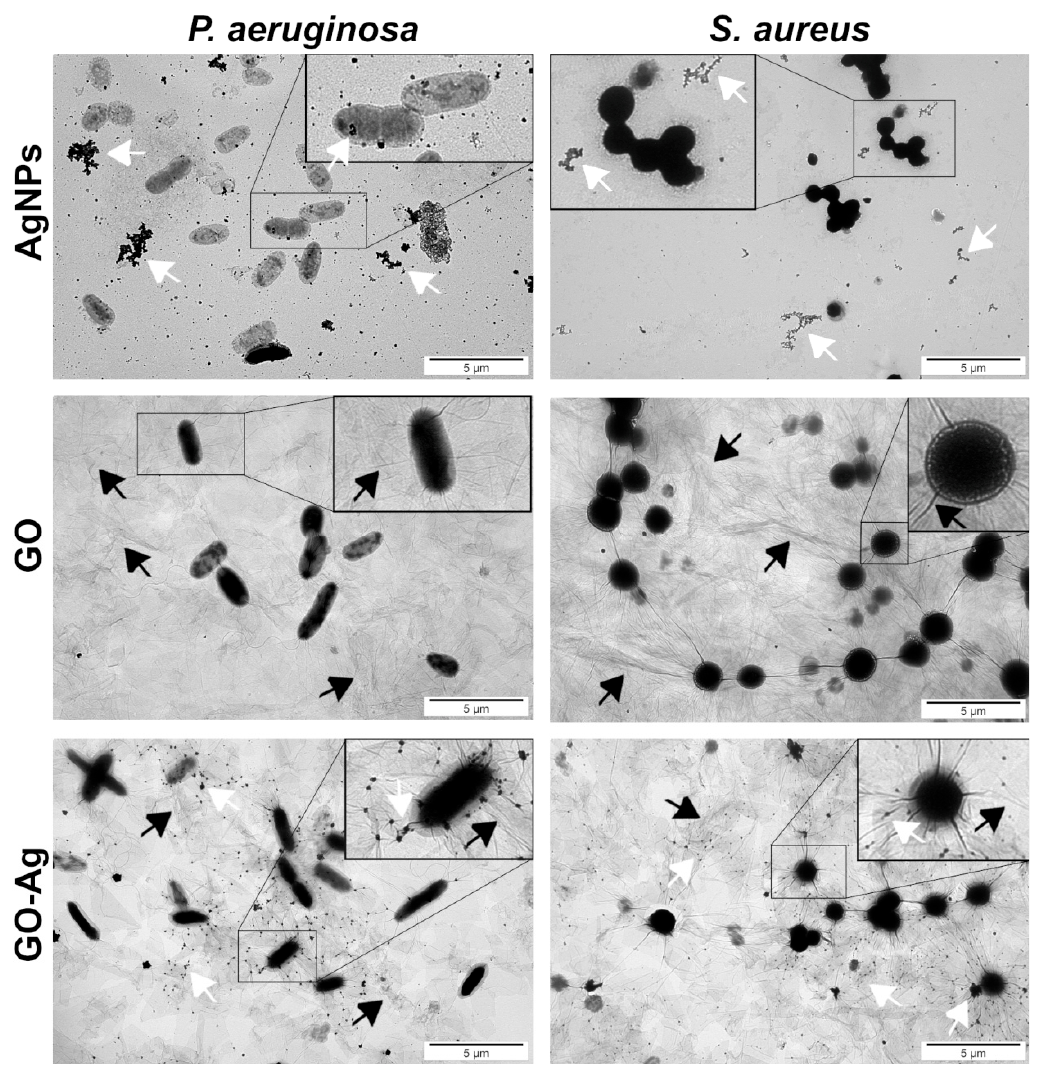
Figure 4. Ultrastructural analysis of bacteria using TEM; silver (AgNPs), graphene oxide (GO) and GO with AgNP complexes (GO-Ag). White arrows point to AgNPs/agglomerates and black arrows point to bending of GO flakes.